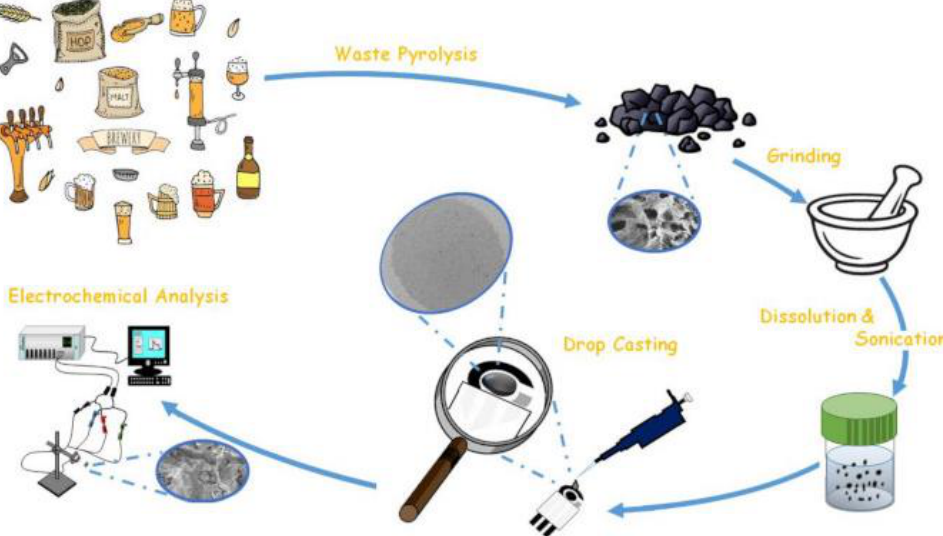
Figure 14. Biochar/SPE preparation scheme. Reprinted with the permission of Elsevier from Ref. [176].